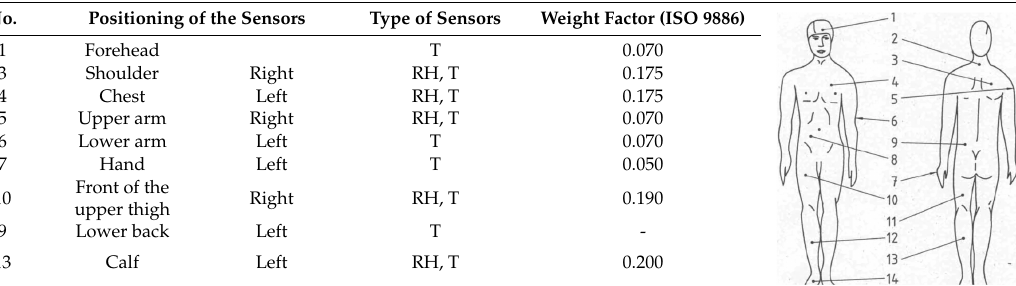
Table 3. Details of sensor position during wear trials and weighting factor for overall skin temperature and humidity (ISO 9886).